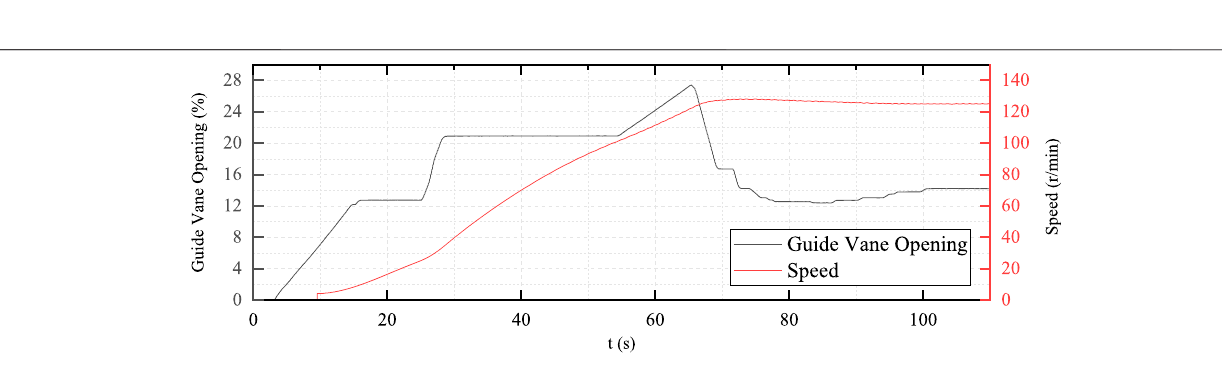
FIGURE 14 | The curve of the guide vane opening and the speed (optimized control mode).